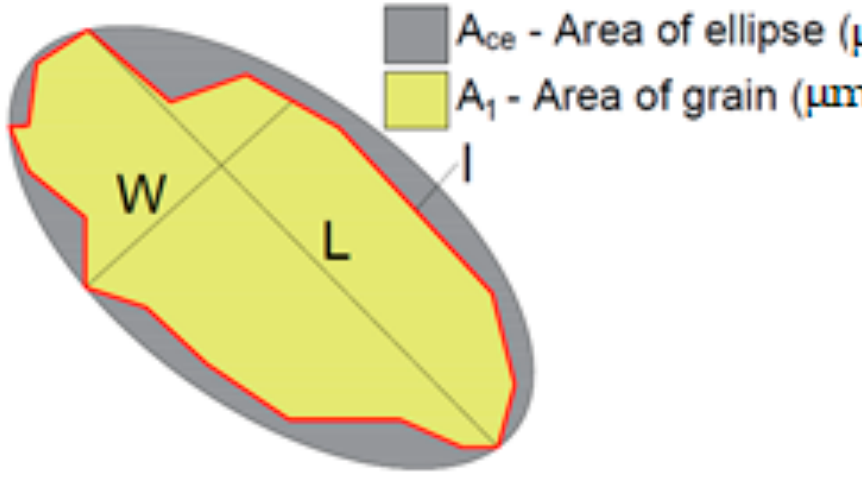
Figure 2. Basic parameters used for the morphological grain